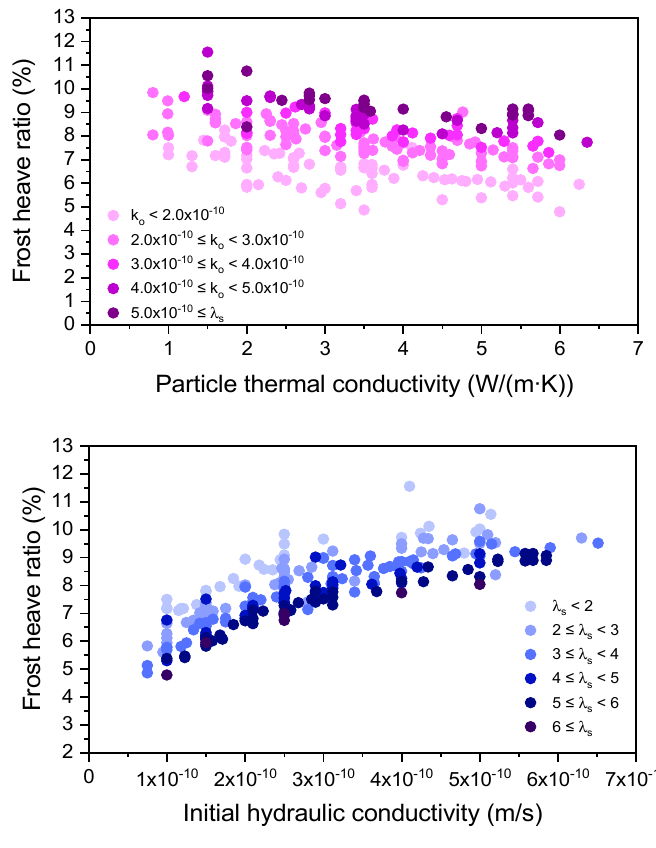
Figure 6. Effect of geotechnical properties on the frost heave ratio. Meanwhile, in order to investigate the sensitivity of both the thermal and hydraulic conductivities of frozen soils on the frost heave ratio, a correlation analysis and